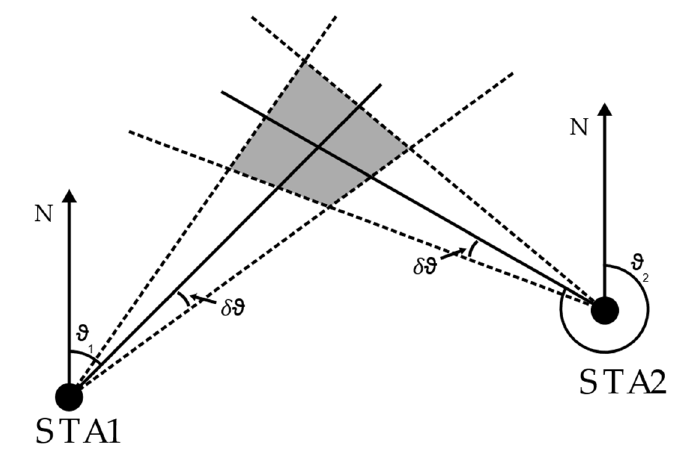
Figure 5. Geometrical representation of the uncertainty assigned to a particular radial intersection arrangement.